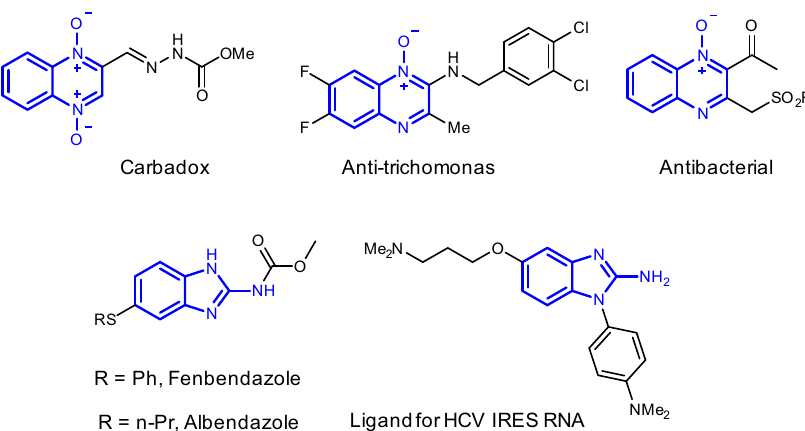
Fig. 2 Related bioactive molecules. The pharmaceutical molecules containing quinoxaline N -oxide or